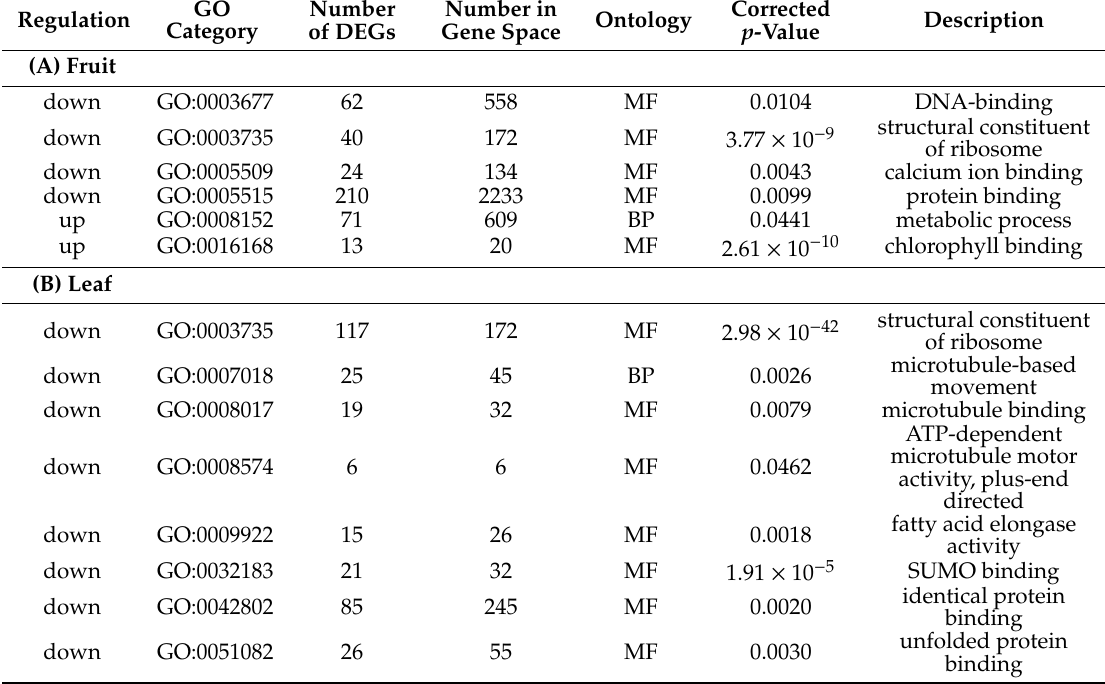
Table 1. Enriched gene ontology (GO) terms within the di ff erentially expressed genes under WD in fruit and leaf